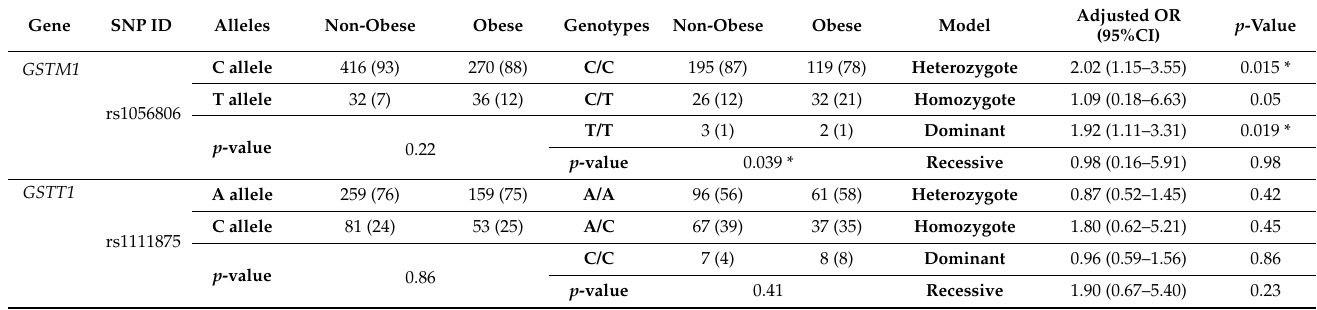
Table 2. Association of gene variant panel with the risk of